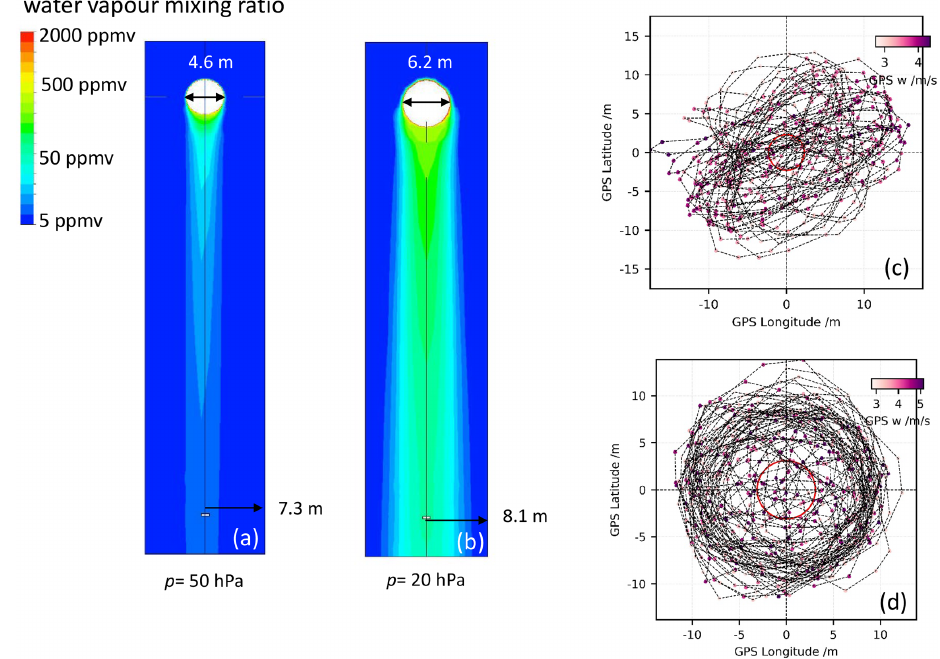
Figure 14. Contamination below a balloon: central cuts through a completely icy balloon and its wake showing the H 2 O mixing ratio (a) at 50hPa and (b) at 20hPa; oscillations of the payload 55m below the balloon measured by GPS during NT007 (c) from 20 to 22km altitude (50hPa level) and (d) from 28 to 31km altitude (20hPa level). Red circle: balloon cross sections at respective pressure levels. Images used courtesy of ANSYS,